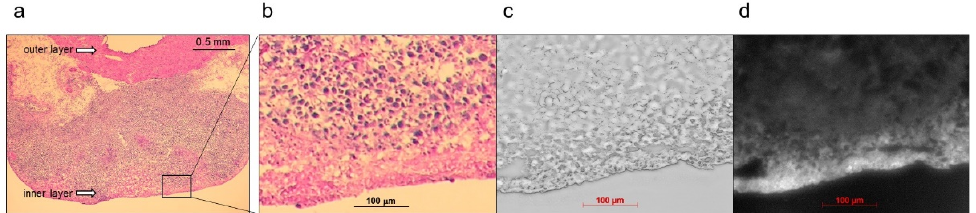
Figure 6. Near-infrared fluorescence (NIRF) intensity in cancerous bladder tissues. ( a ) Bladder inner layer under white light. ( b ) NIRF intensity on yellow line in ( a , c ). ( c ) NIRF image of bladder inner layer shown in photo ( a ). Scale bar in photos ( a , c ) represents 10 mm. Yellow arrows in photo ( a ) show points of boundary between NIRF and non-NIRF based on the photo ( c ). Red lines are scale lines common to ( a – c ).